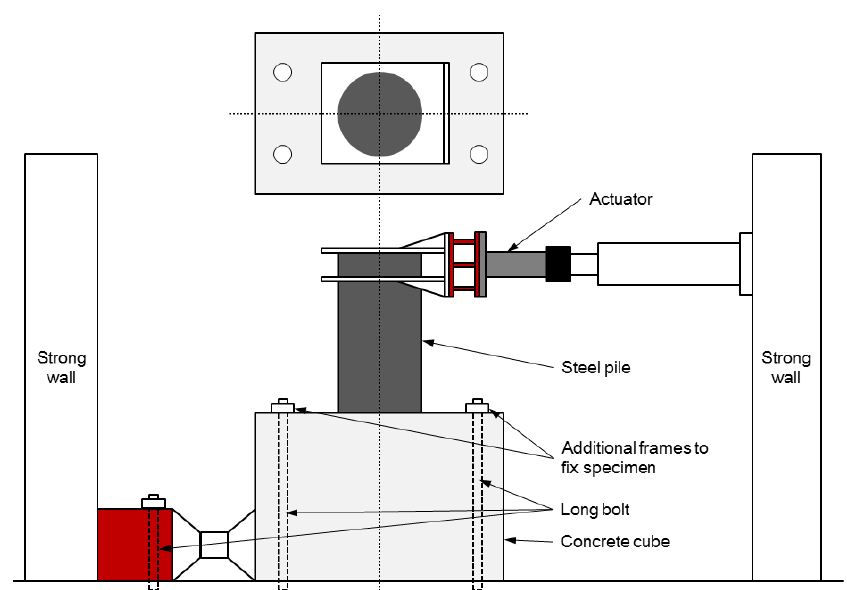
Figure 5. Test setup.